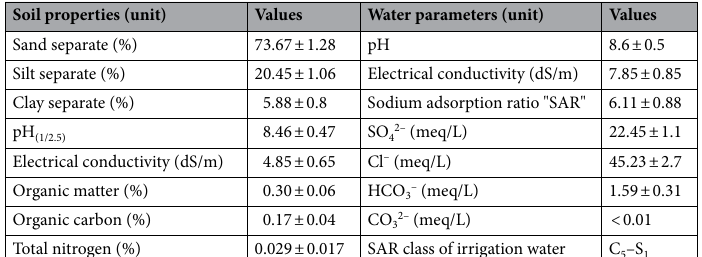
Soil properties